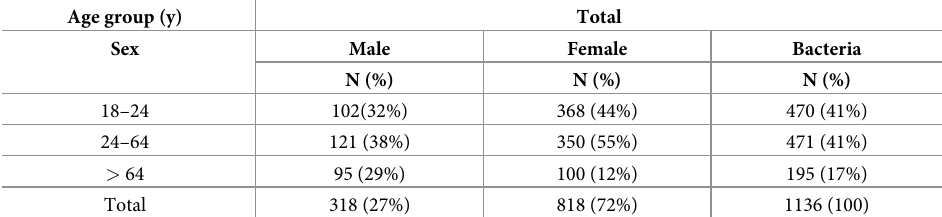
Table 1. Age and sex distribution of patients with bacterial